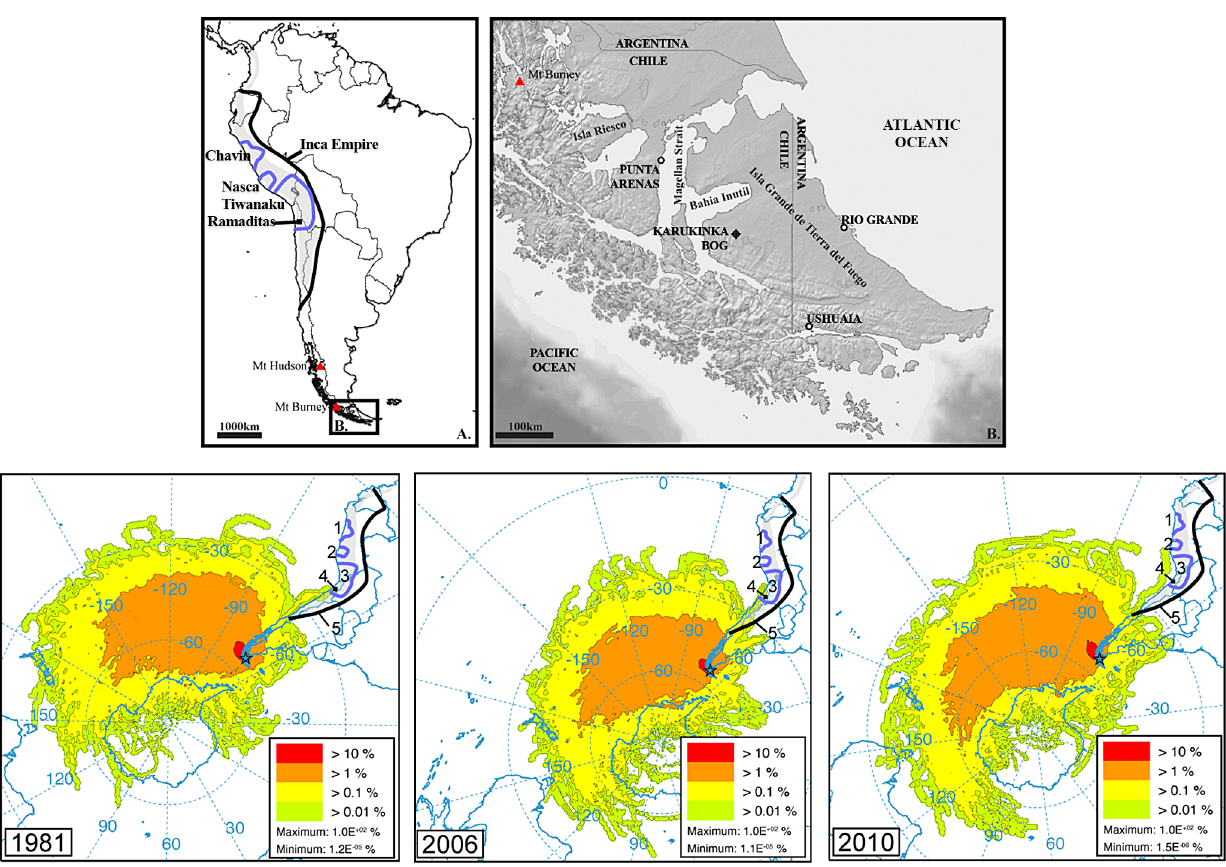
Figure 1. Upper Panel: A. Main polymetallic ores in South America (grey shaded area) and the extent of pre-Colombian civilisations and cultures discussed in the text (dark blue lines: 1-Chavin, 2-Nazca, 3-Tiwanaku; black square: 4-Ramaditas site black line: 5-Incas). B. Location of Karukinka bog in Tierra del Fuego. Lower Panel: back-trajectories for years when significant parcels of air masses travelled from NSA, specifically from the Inca, Tiwanaku and Nazca territories as well as from the Ramaditas site. Only the three most representative years are shown (see figure S1 for all years from 1948 to 2012). Other years (1997, 1999, 2000, 2008) are displayed in Fig. 3.